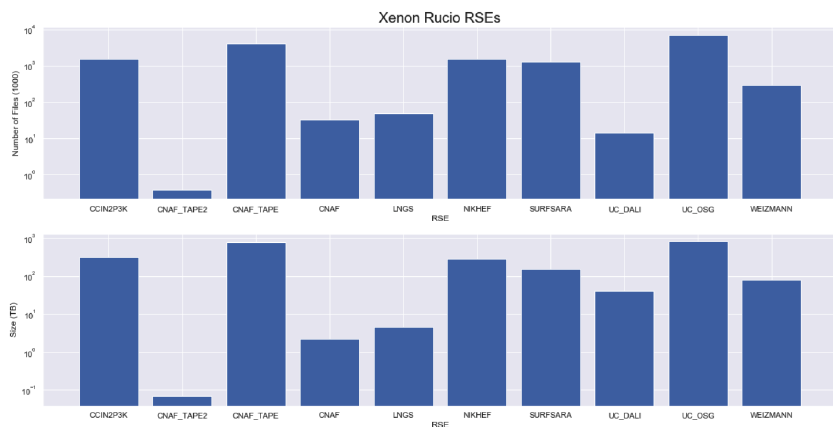
Figure 4. Rucio RSE utilization for the XENON1T data. During the 2 years of operations, the exper- iment has produced over 800 TB of data which are managed by Rucio. Top: Number of files in each RSE endpoint. Bottom: Storage utilization in TB for each RSE